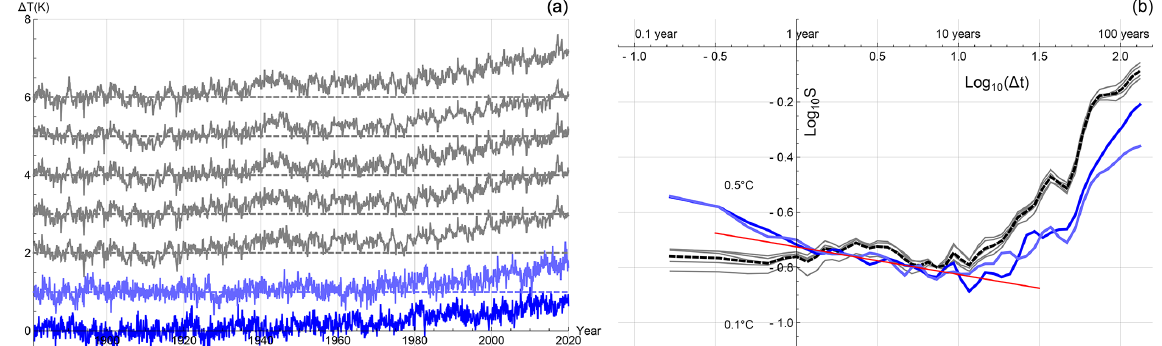
Figure 10. (a) The historical reconstruction (forced and internal temperature response) of the FEBE, with parameters calibrated using F Aer (light blue) alongside the five observational temperature series (grey – shifted up) at monthly resolution. (b) The (blue) and F Aer SSP RCP root mean square Haar fluctuation structure function S ( (cid:49)t ) = (cid:104) (cid:49)T ( (cid:49)t ) 2 (cid:105) blue), and the five globally averaged monthly resolution temperature time series (grey; mean is shown in dashed black). The reference (red) line has the slope of the approximate median estimate of the scaling exponent h ≈ 0 . 4 ( H = h − 1 variability) is not expected to be identical; only its statistical character (correlations) and amplitude are expected to be the same as the data.